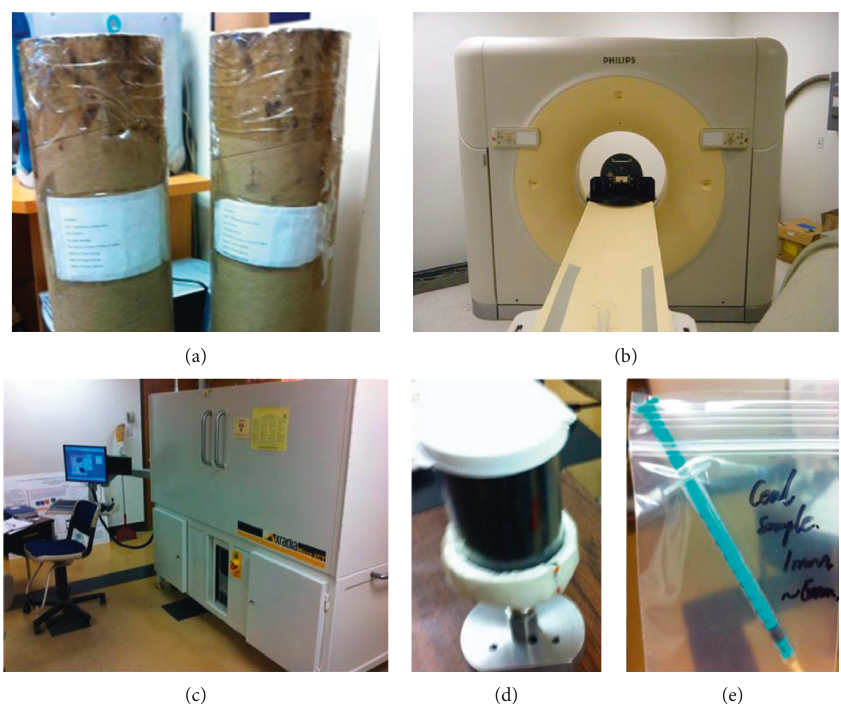
Figure 1: CTscanning facilities used (a) presents the raw coal gangue samples; (b) presents the Philips Tomoscan 60/TX CTscanner for raw samples; (c) presents the micro-XCT-400 scanner for crushed particles; (d) presents the 40 mm diameter container for fine CGPs samples; and (e) presents the 5mm diameter container for fine CGPs.